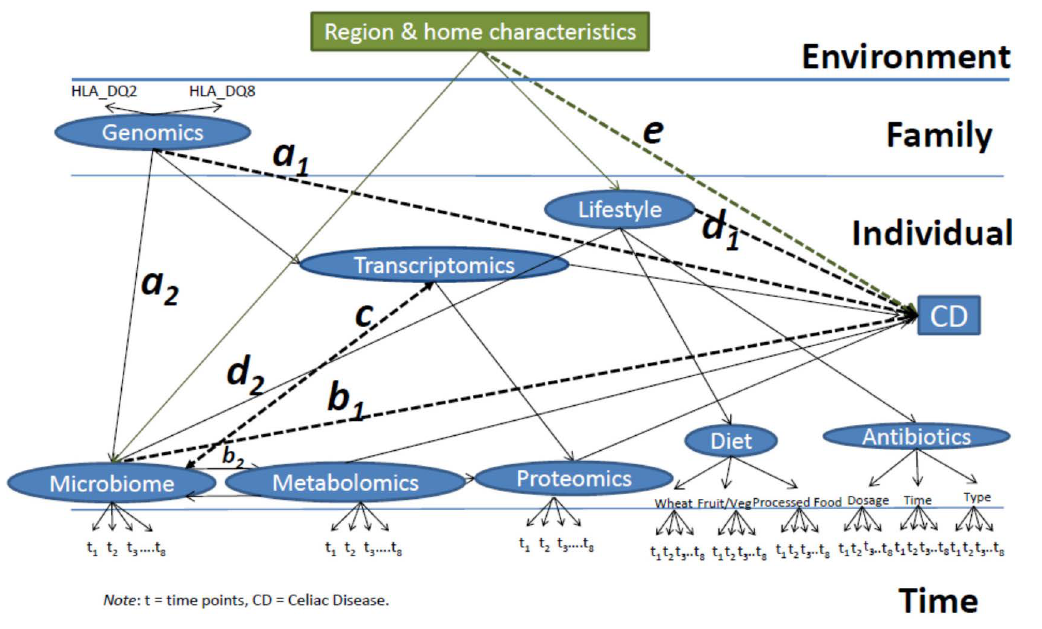
Figure 3. Celiac Disease Genomic, Environmental, Microbiome, and Metabolomic (CDGEMM) Integrative Multilevel Model to Predict Celiac